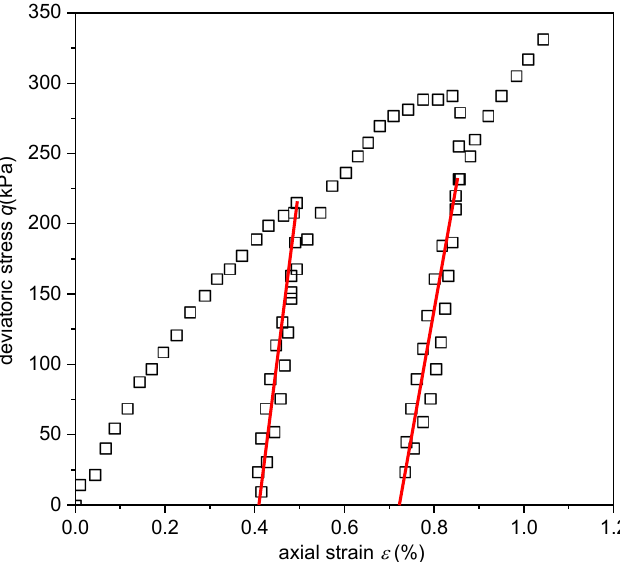
Figure 6. Loading-unloading-reloading experimental curve of sandy gravel.